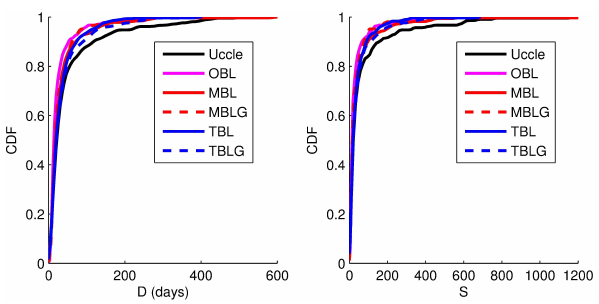
Fig. 7. Comparison of Kernel cumulative distribution functions of D and S of observed and simulated